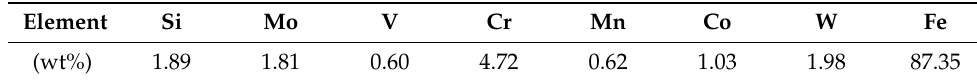
Table 2. The chemical composition (wt%) of H13 tool steel.